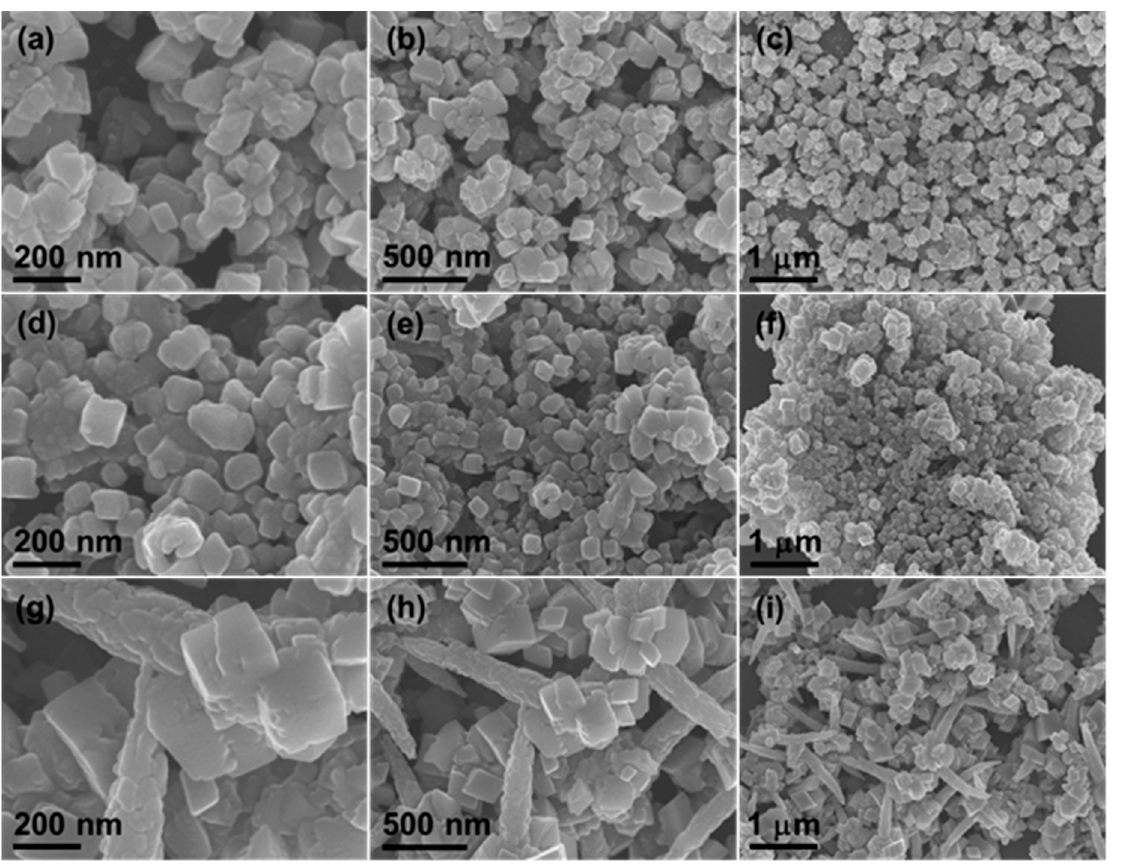
Figure 6. SEM images of CONPs from calcium oleate at different temperatures: ( a – c ) 700 °C, ( d – f ) 750 ° C, and ( g – i ) 800 ° C. ( d – f ) 750 ◦ C, and ( g – i ) 800 ◦